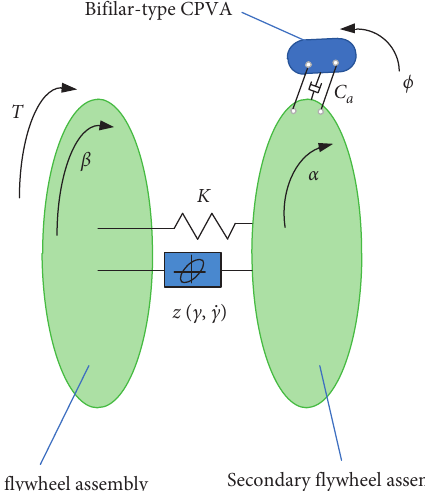
Figure 3: Dynamic model of the DMF with a bifilar-type CPVA.